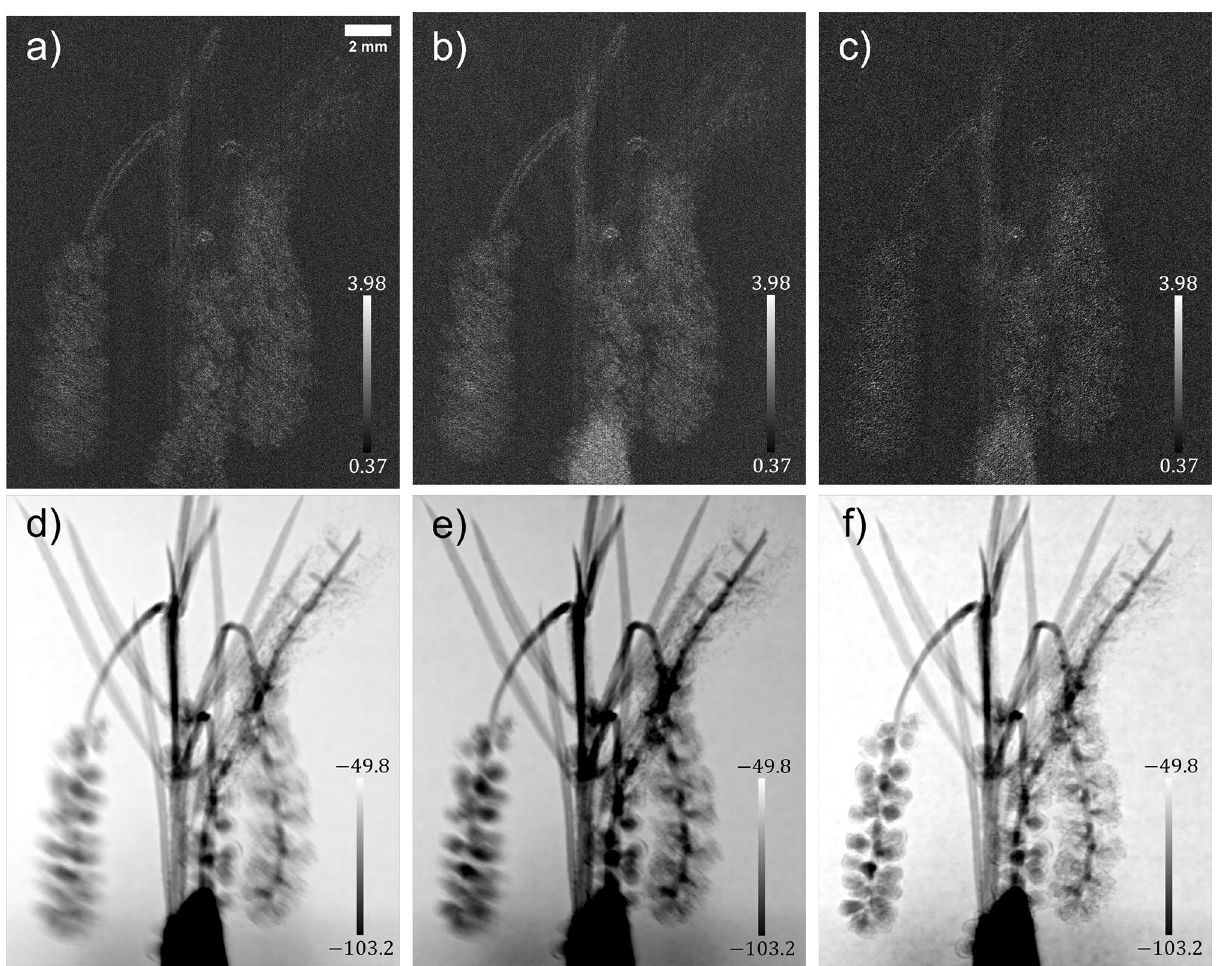
Figure 4. Comparison of wattle-flower multimodal signals extracted using the MIST approaches for rotationally-isotropic diffuse scatter: ( a – c ) are reconstructed effective diffusion coefficients, and ( d – f ) are phase- shifts (as the wattle flower is a pure phase-object). ( a , d ) use Pavlov et al. ’s 36 approach, which neglects X-ray attenuation, and ( b , e ) use Alloo et al. ’s 42 approach, which considers it; both approaches assume the effective diffusion coefficient to be slowly varying. ( c , f ) are calculated using the present approach, which considers weak X-ray attenuation and does not approximate the diffusion coefficient as slowly varying. The greyscale bars in ( a – c ) are × 10 − 5 µ m and ( d – f ) are × 10 0